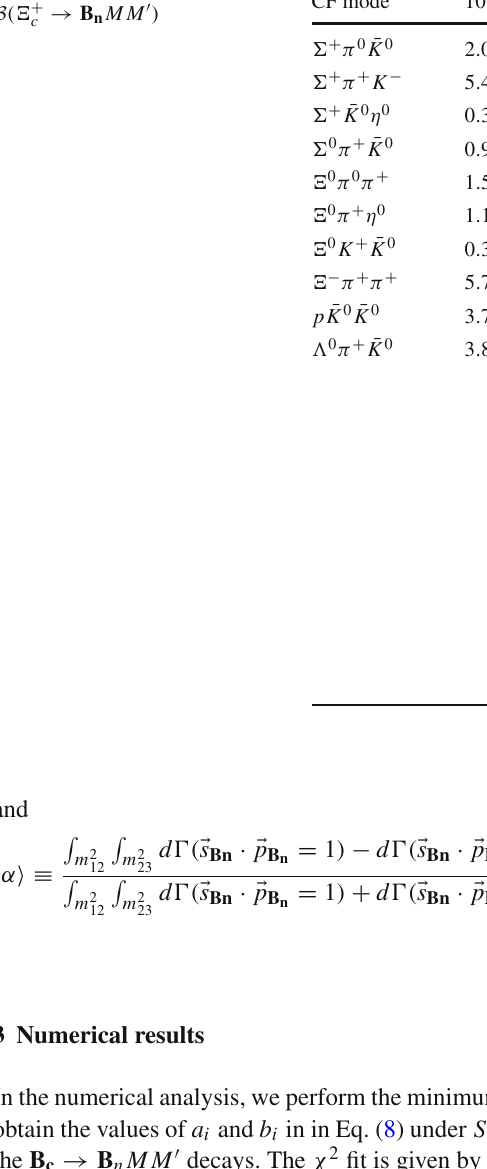
Table 7 Numerical results for (cid:3) → B B ((cid:2) + n MM c